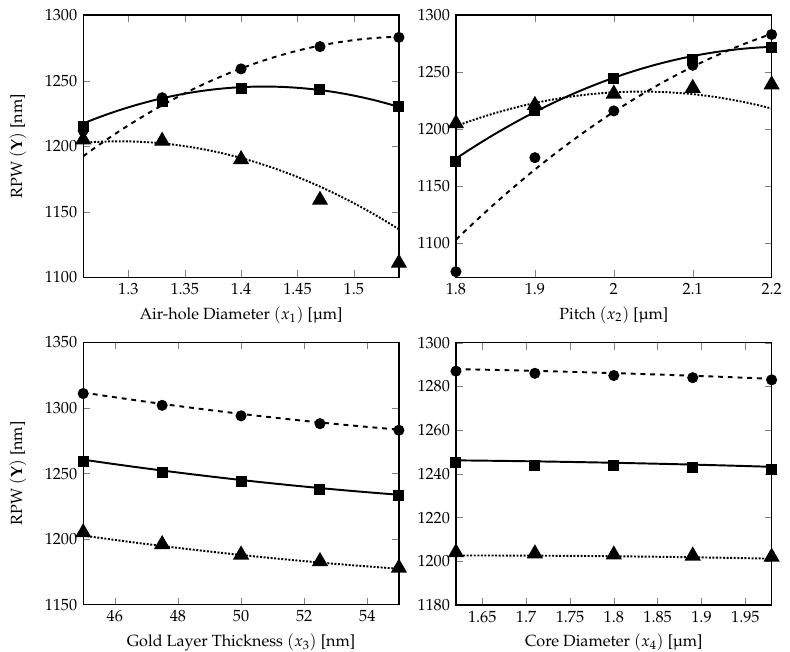
Figure 8. Effects of four factors (air-hole diameter, pitch, gold layer thickness and core diameter of analyte) on RPW curves generated from quadratic CCD ± 10% model. The dotted, solid and dashed curves show the RPW calculated from the ± 2% DoE model (13) with three parameters (expected target parameter on x -axis) fixed at their own tolerance levels, − 10%, 0% and + 10%, respectively. The RPW −→ + 10%) are calculated from corresponding FEM marks ( (cid:78) −→ − 10%, (cid:4) −→ 0% and (cid:32)